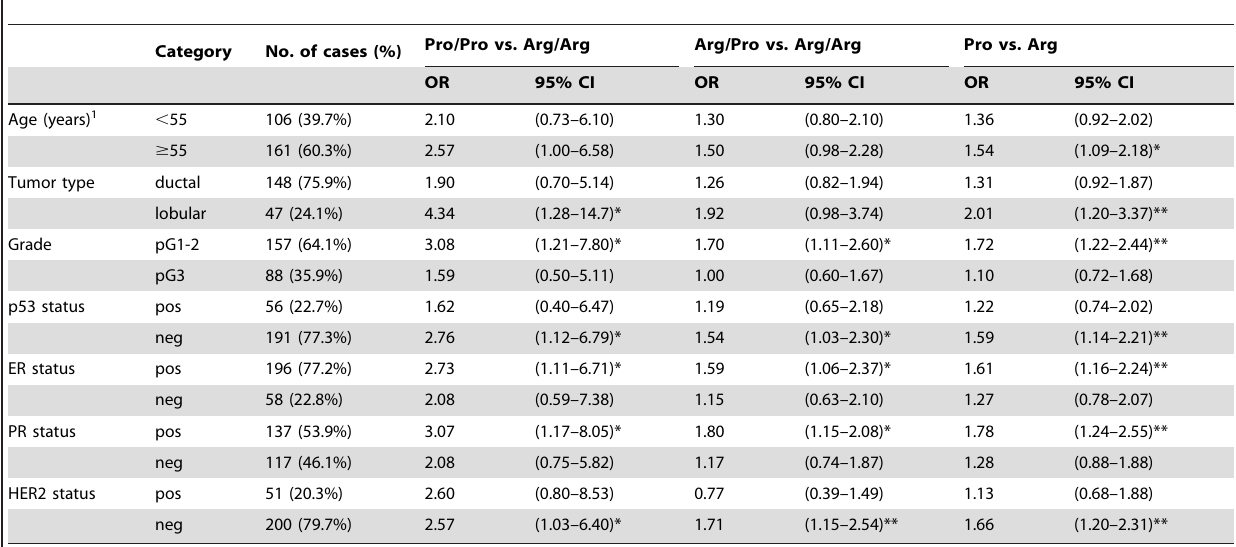
Table 3. Association of the TP53 Arg72Propolymorphism with breast cancer risk in the indicated subgroups.